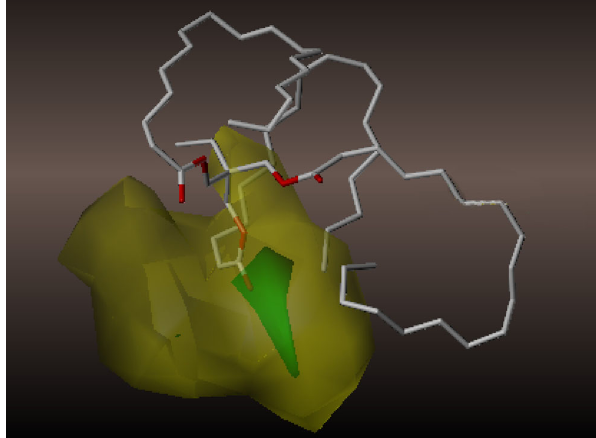
Fig. 44 CoMSIA contour diagram for friction with embedded TMPTO as reference for steric field. Green and yellow regions show where steric bulk is favored and disfavored,